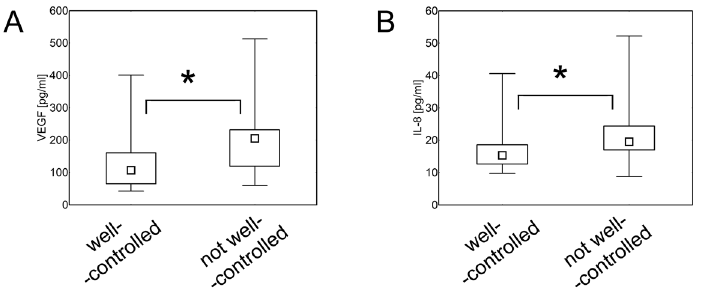
Fig 4. Control of hypertension and serum concentration of cytokines. Patients with well controlled hypertension had lower serum levels of VEGF (A) and IL = 8 (B) (Mann- Whitney U test; p = 8x10 -3 and p = 7x10 -3 , respectively) in comparison with individuals with not well-controlled hypertension. The data are presented as medians (symbols inside the boxes), 25 – 75% percentiles (boundaries of the boxes) and minimum — maximum (error bars outside the boxes). Statistical significance (p < 0.05) is marked with “ * ” .